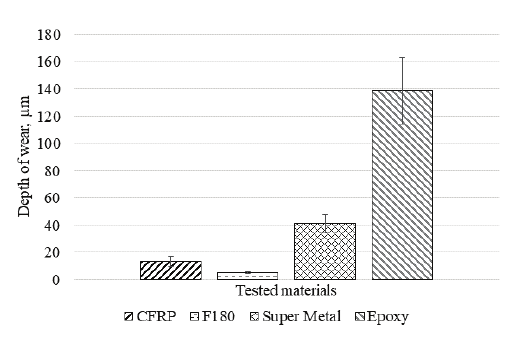
Figure 11. 3D scan of the friction path surface for CFRP material